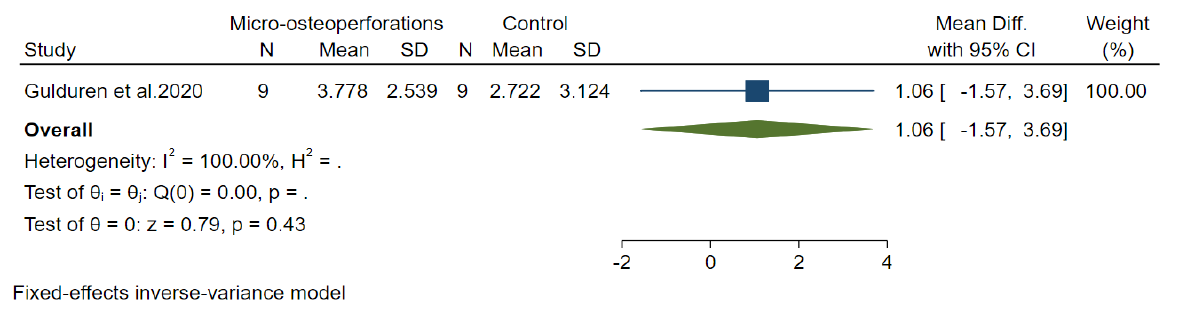
Figure 4. Mean difference of pain level in MOP group vs. control